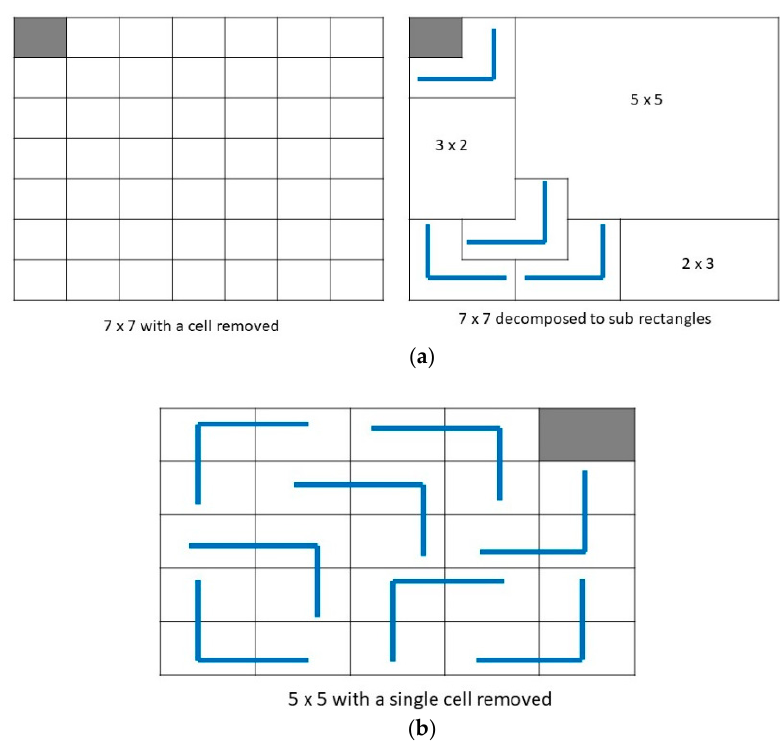
Figure 5. Image Argument for Lemma 3. ( a ) Decomposing an a × b rectangle according to Lemma 3; ( b ) A 5 × 5 modified tiled rectangle.